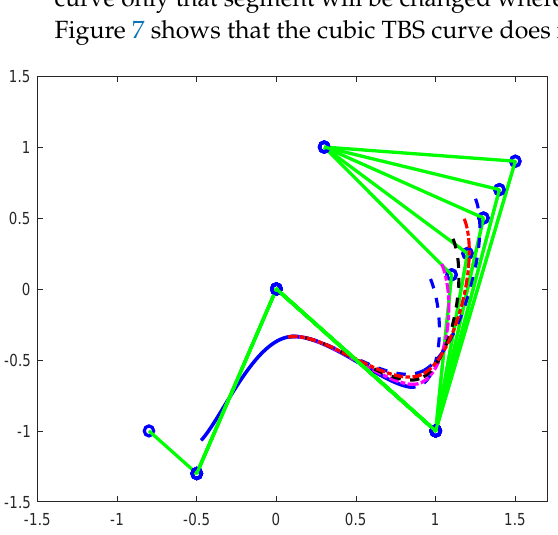
Figure 7. Local control